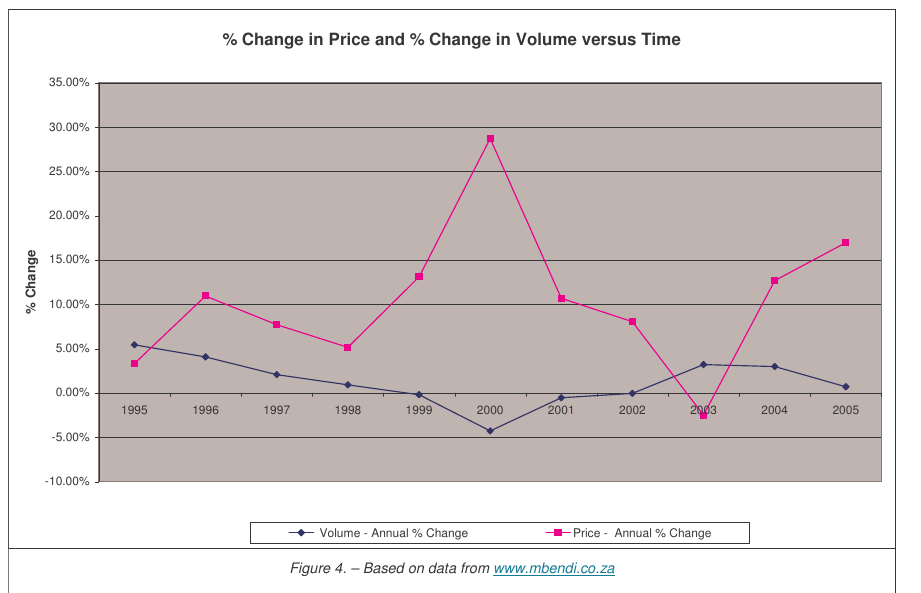
Figure 4. – Based on data from www.mbendi.co.za